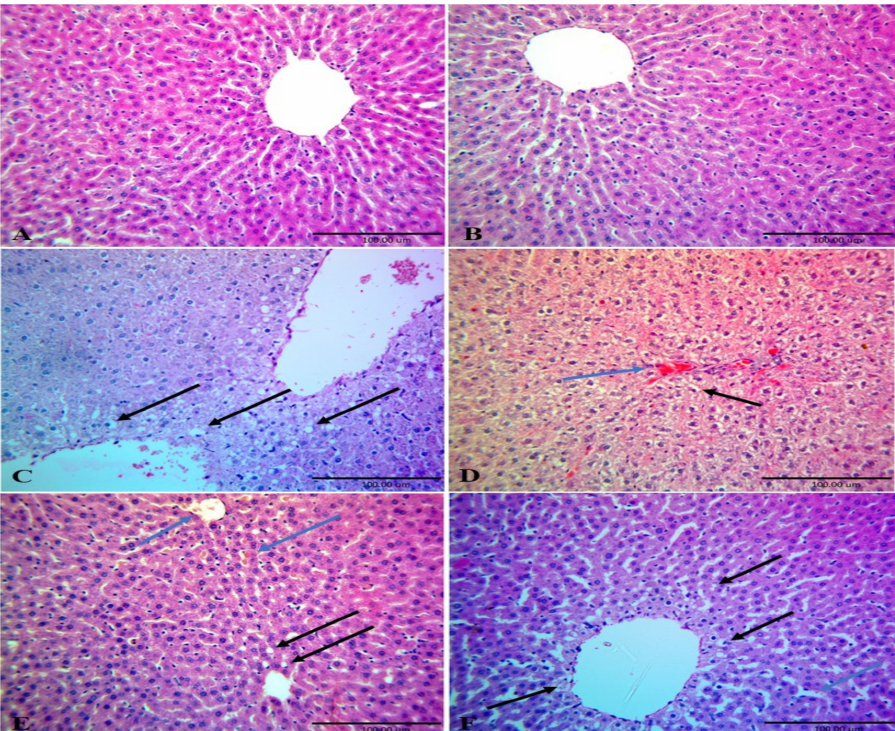
Figure 4. Photomicrograph of liver tissues sections of di ff erent groups stained with H&E. Rats were reared, fed and treated as in Figure 1. Livers tissues of normal control group ( A ) CME treated group ( B ) showed normal hepatic tissue. Livers sections of HFD group ( C and D ) showed congested blood vessels (blue arrow) with di ff use fatty change of hepatocytes (black arrow). Livers tissues sections of group HFD and CME treated group ( E ) showed slight congestion of central vein and hepatic sinusoids (blue arrow), some hepatocytes showed fatty change (black arrow). Liver tissues sections of HFD then normal diet + CME group ( F ) showed dilated hepatic sinusoids (blue arrow), hepatocytes showed multiple fat globules appear as clear vacuoles of di ff erent size (black arrow) (X40). 3.7. Commiphora myrrha Resin Extract Increased UCP1 Protein Expression in Brown Adipose Tissue of